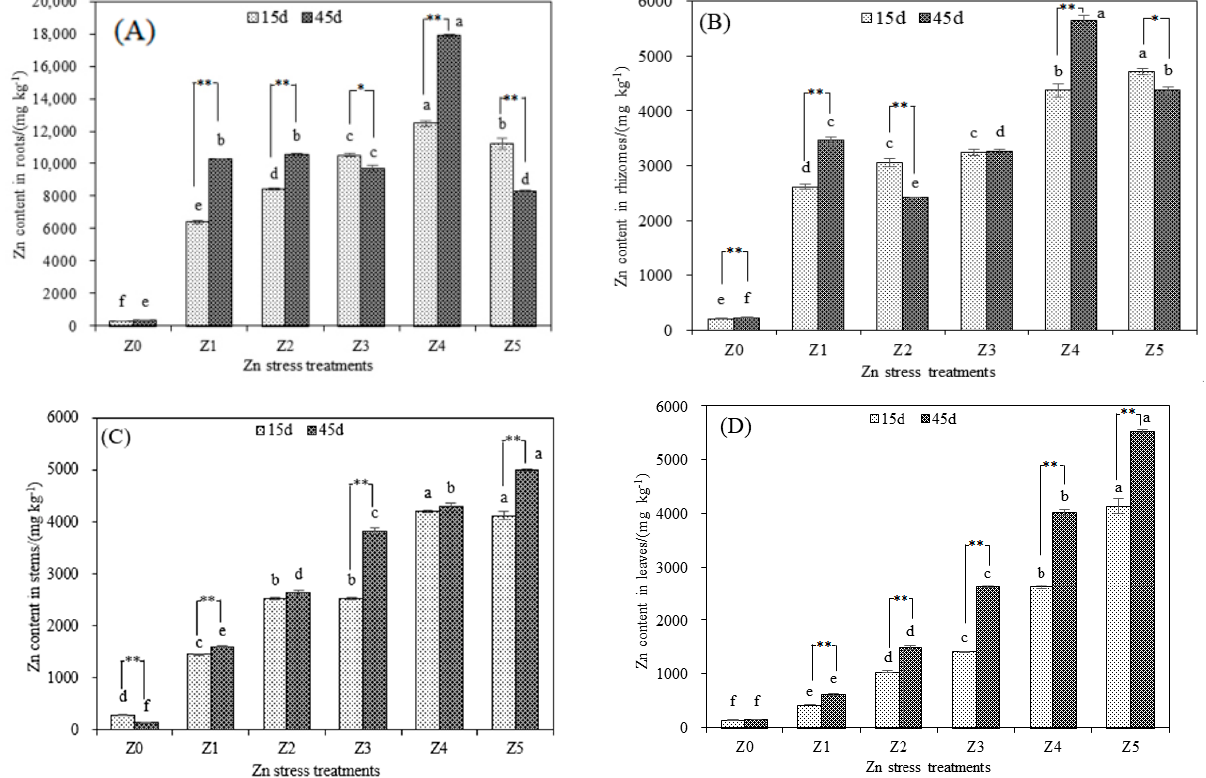
Figure 2. Impacts of different treatment times and Zn treatments on Zn content in roots ( A ), Zn content in rhizomes ( B ), Zn content in stems ( C ) and Zn content in leaves ( D ). Along the x -axis of each graph, Z0, Z1, Z2, Z3, Z4 and Z5 indicate that the Zn concentrations are 0 (or control), 75, 150, 300, 600 and 1000 mg/L, respectively. Vertical bars represent the standard errors of the mean ( n = 3). Different letters indicate significant differences among treatments with different Zn concentrations under the same treatment time ( p < 0.05). * indicates a significant difference at 0.05 under the same treatment and different time ( p < 0.05). ** indicates an extremely significant difference at 0.01 under the same treatment and different time ( p < 0.01). Table 1. Impacts of different treatment times and Zn treatments on the bioaccumulation factor in four organs. Z1, Z2, Z3, Z4 and Z5 indicate that the Zn concentrations are 75, 150, 300, 600 and 1000 mg/L,